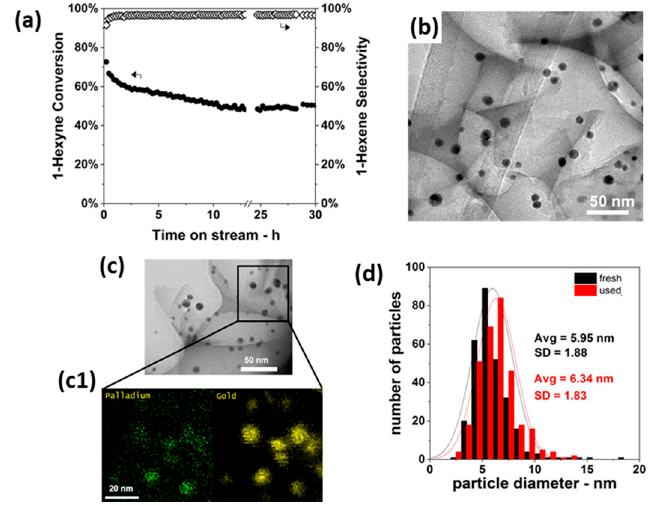
Figure 12. ( a ) 1-hexyne conversion and 1-hexene selectivities in 1-hexyne partial hydrogenation as a function of TOS for Pd 0.04 Au 0.96 RCT-SiO 2 . Reaction conditions: T = 90 °C, P = 1 atm, 1% ( V / V ) 1-hexyne; 20% ( V / V ) H 2 , He balance, m cat = 20 mg, total flow rate = 50 mL min − 1 , GHSV = 3800 h − 1 . ( b ) TEM of fresh Pd 0.04 Au 0.96 RCT-SiO 2 . ( c ) TEM of Pd 0.04 Au 0.96 RCT-SiO 2 after the stability test in (a); ( c1 ) STEM-EDX color mapping of (c); green: Pd; yellow: Au. ( d ) Particle size distributions of fresh and used Pd 0.04 Au 0.96 RCT-SiO 2 . Adapted with permission from Ref. [182]. Copyright 2020 American Chemical Society.